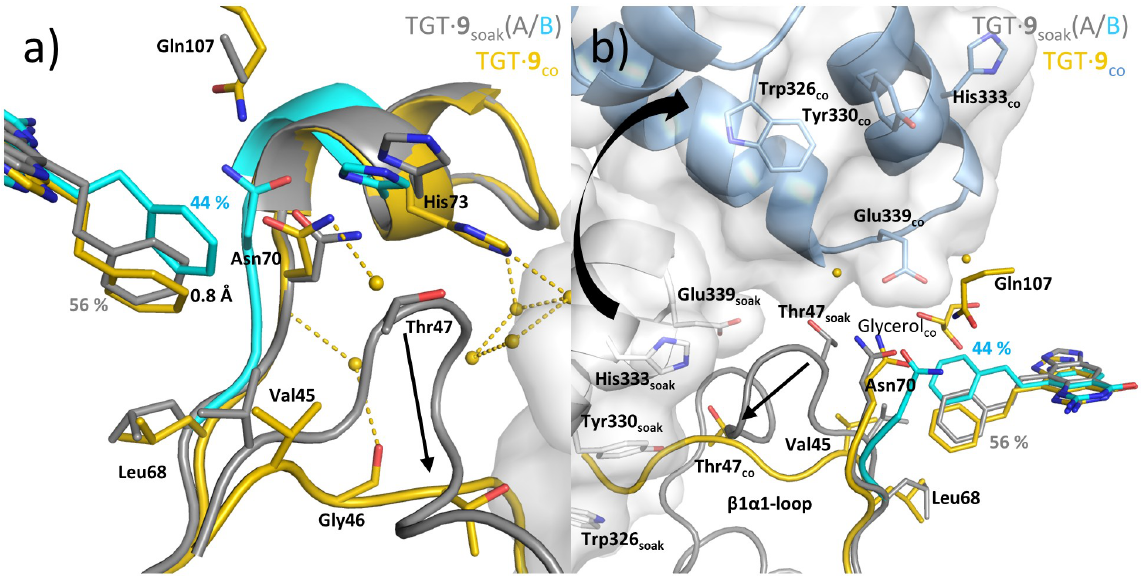
Fig 4. Binding modes and structural rearrangements of 9. a) TGT (cid:1) 9 soak (conformation A gray and conformation B cyan) and TGT (cid:1) 9 co (yellow), b) View from an alternative directionincludingthe second monomerof TGT (cid:1) 9 co in light blue and with gray solvent accessiblesurface. Black arrows indicate positional differencesbetweenthe crystal structures of different crystallization protocols. Inhibitor 9 displacesthe β 1 α 1-loopin the co-crystal structure and triggers the formation of a new twisted dimer (see Figure 4d). Yellow dashedlines indicate H-bondsfrom selectedwater molecules(2.7–3.4 Å ).